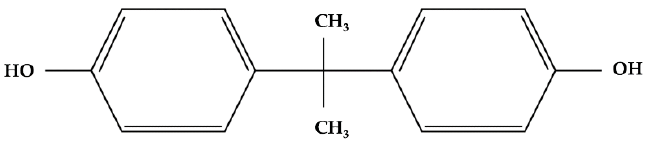
Figure 1. Structure of bisphenol A